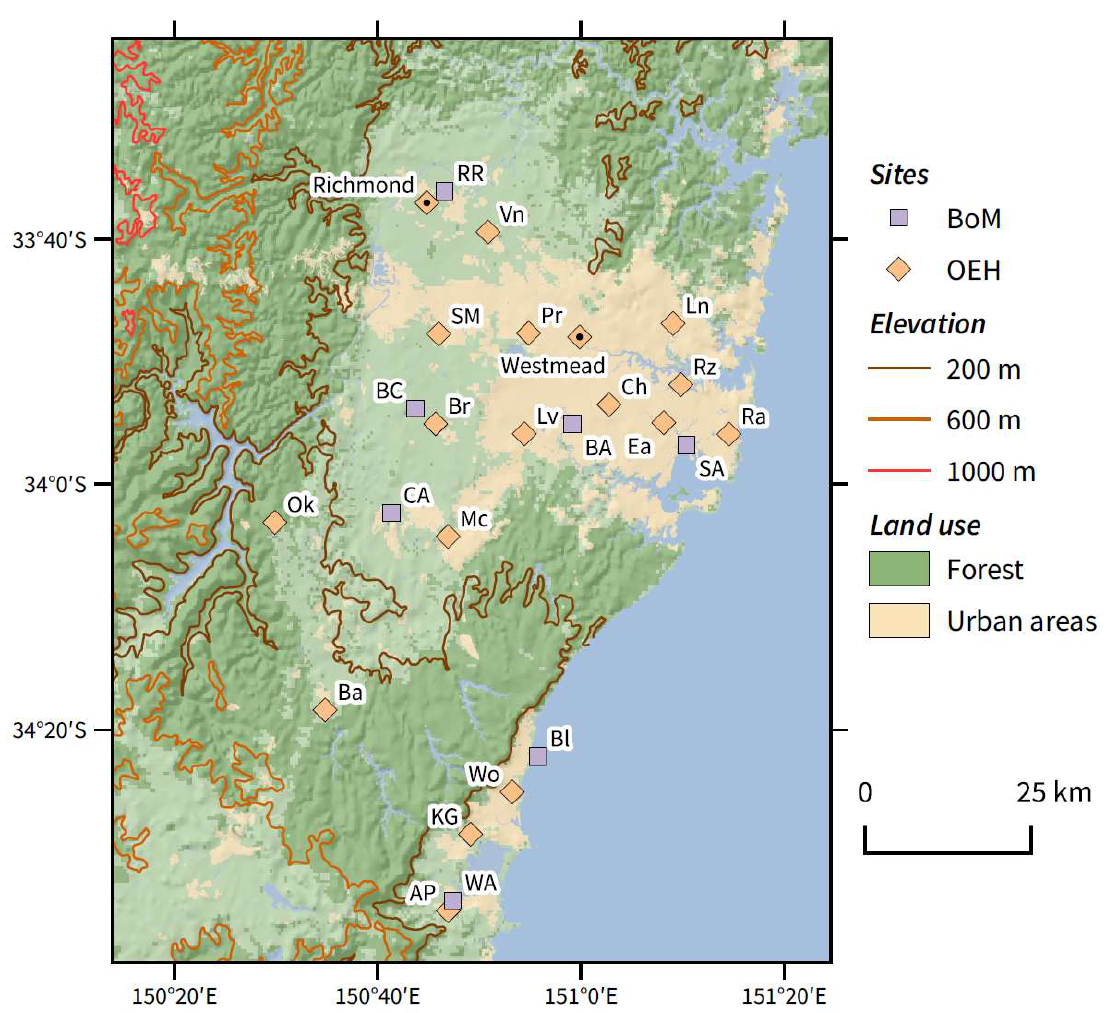
Figure 1. Location of monitoring sites used for the SPS campaigns in the Greater Sydney Region (including those operated by BoM and NSW OEH). A key for site abbreviations is provided at the end of this document. Land cover is derived from the MODIS satellite data [32], topography from Geoscience Australia [33], and basemap © OpenStreetMap contributors.